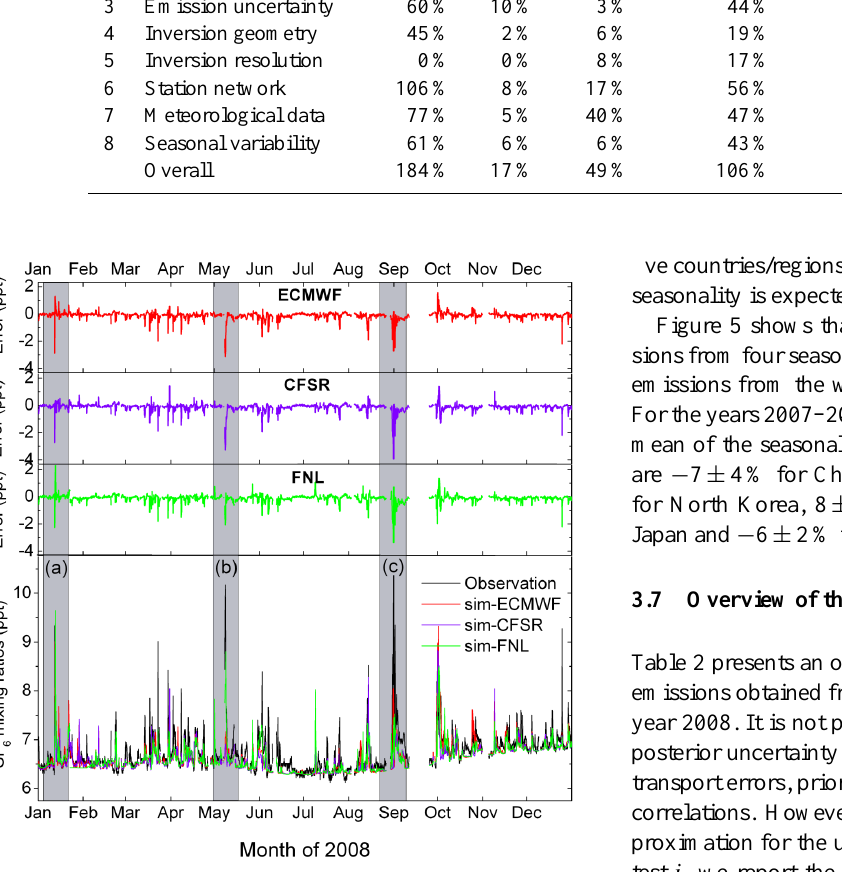
Fig. 4. Observed and simulated SF 6 mixing ratio time series at Hateruma station when using ECMWF, CFSR and FNL meteorological data for 2008. Pollution episodes labeled (a), (b) and (c) were best simulated by using CFSR, FNL and ECMWF data set, respectively.